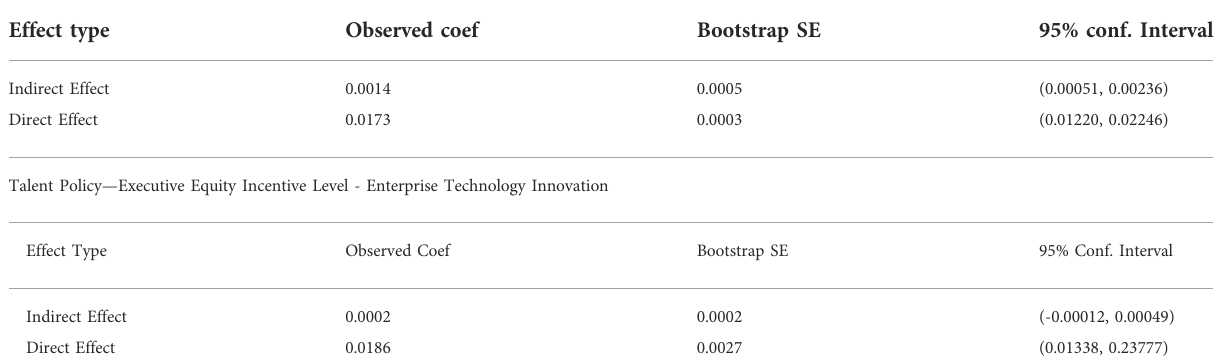
TABLE 5 Bootstrap test method.